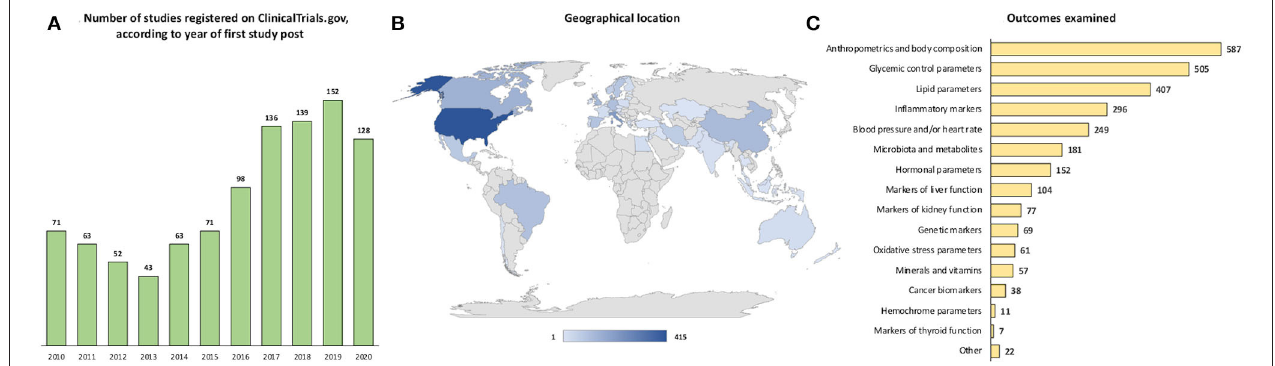
FIGURE 2 | Number of studies registered on ClinicalTrials.gov, according to (A) year of first study post, (B) geographical location, and (C) examined